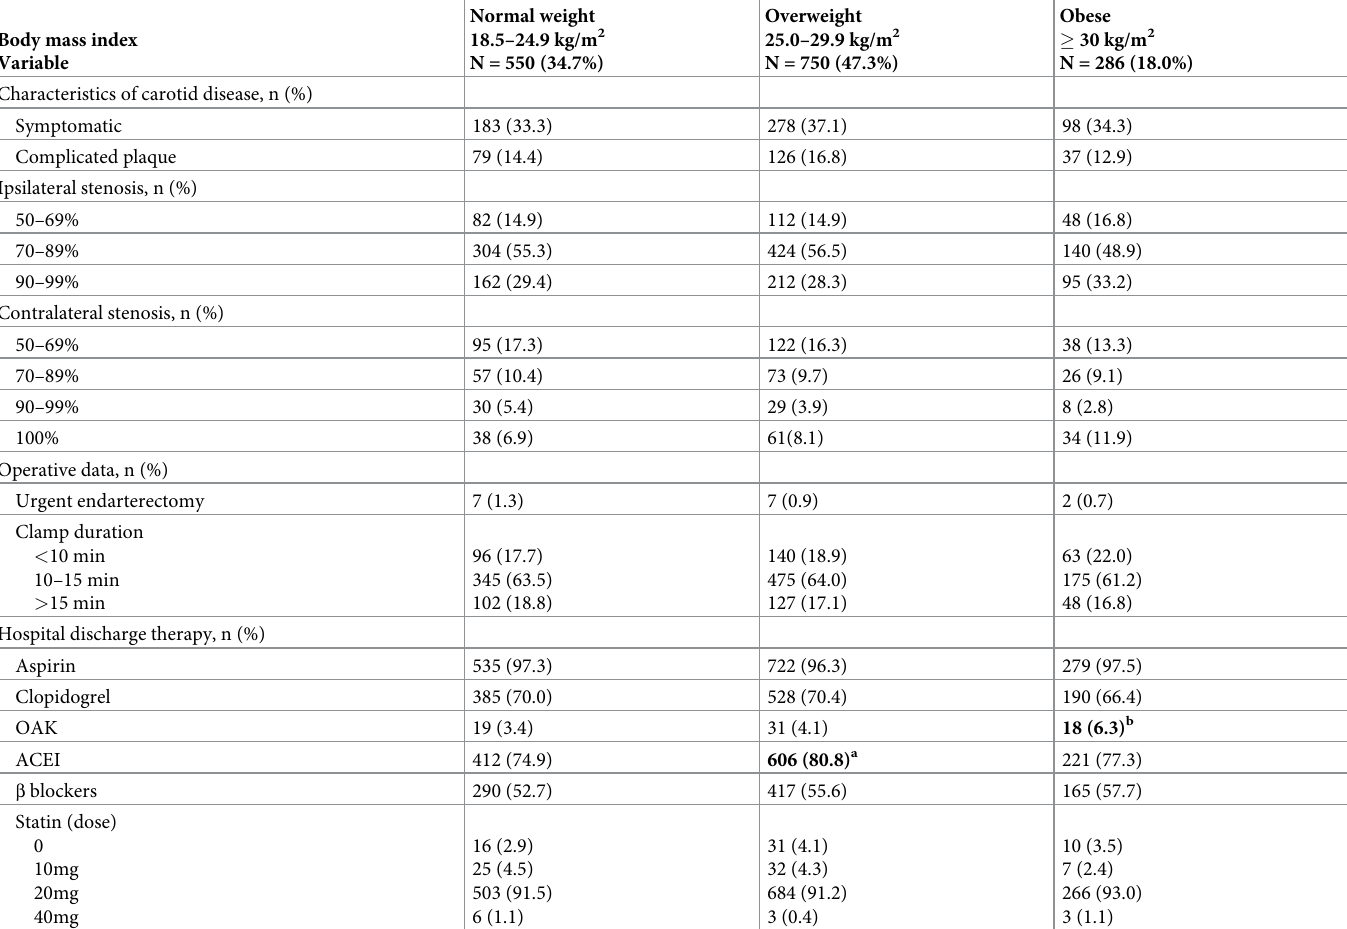
Table 2. Characteristics of carotid disease, operative data, and hospital discharge therapy by body mass index � .